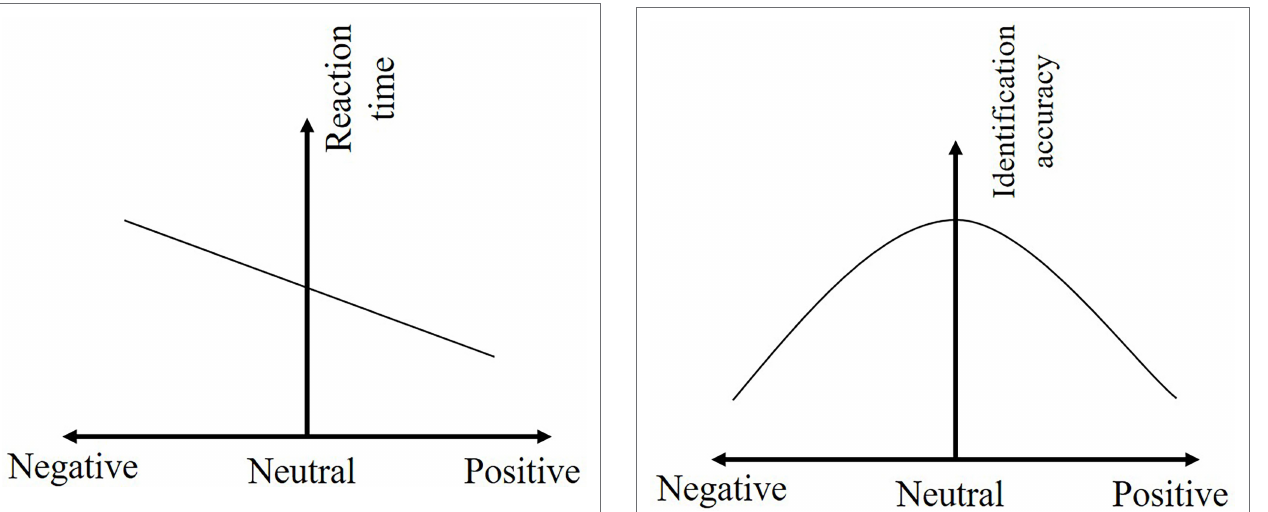
FIGURE 10 | The effect of emotional valence on the identification